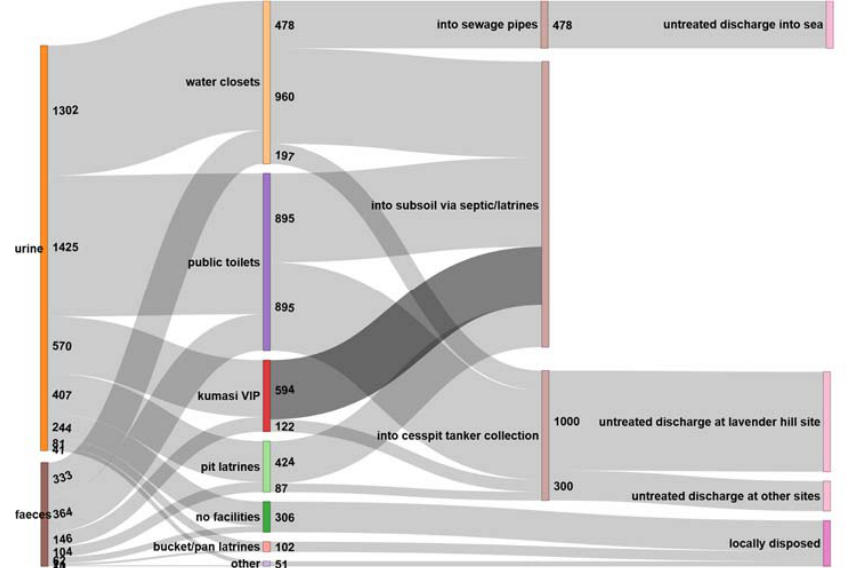
Figure 5. Sankey diagram from 2010 GAMA human excreta generation to final discharge flows in m 3 per day. A Kumasi Ventilated Improved Pit (VIP) is designed with two pits versus a single-pit VIP.